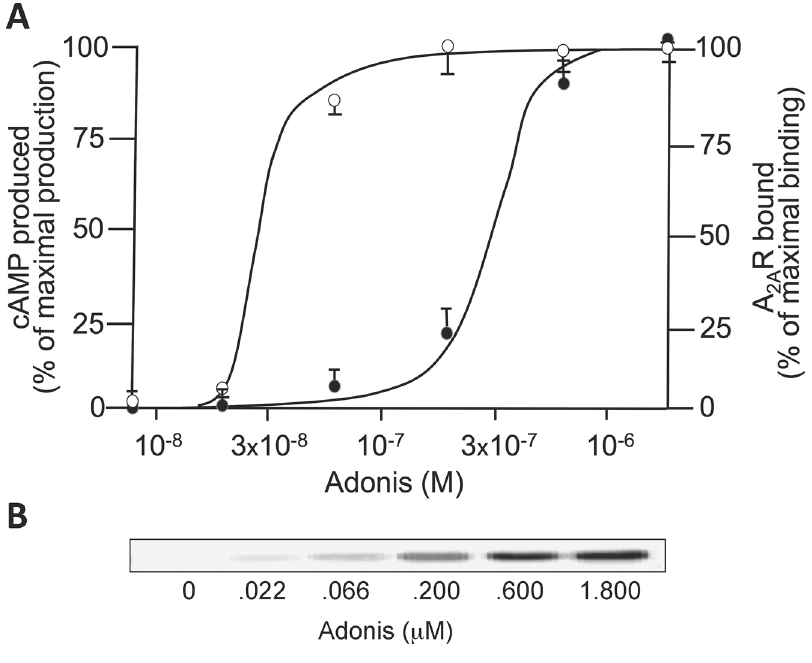
R in patients with positive EST. (A) The dose- 2A R (K ; black circles; densitometry 2A D ; white circles) for a represen- 50 ≤ 0.1) is shown. Results are mean ± SD of tripli- R (EC /K 2A 50 D determination is D